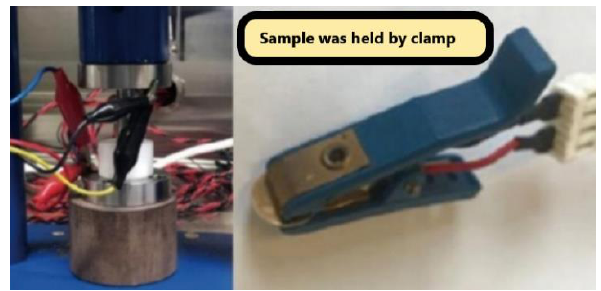
Figure 12. Setup for traditional ionic conductivity measurement.